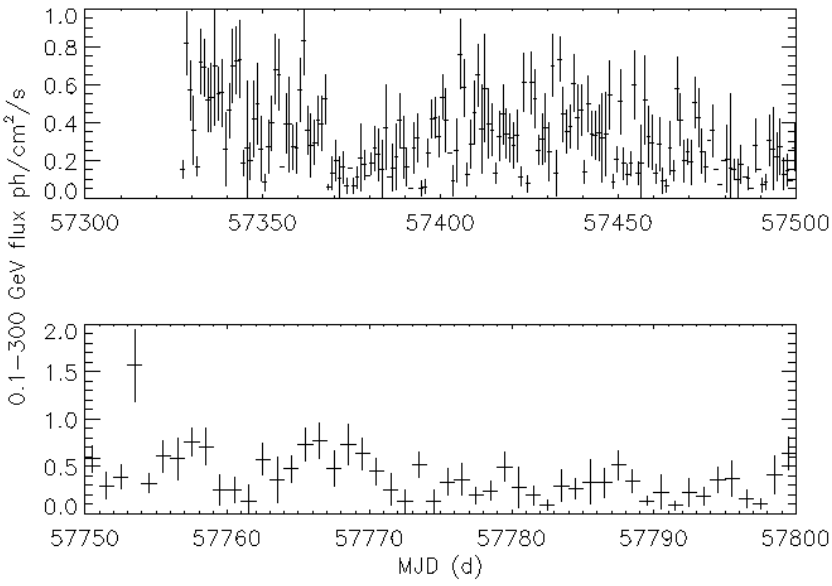
Figure 8. One day binned Fermi -LAT light curve in the energy range of 0.1–300 GeV during 1 November 2015–22 April 2016 ( top panel ) and 28 December 2016–15 February 2017 ( bottom panel